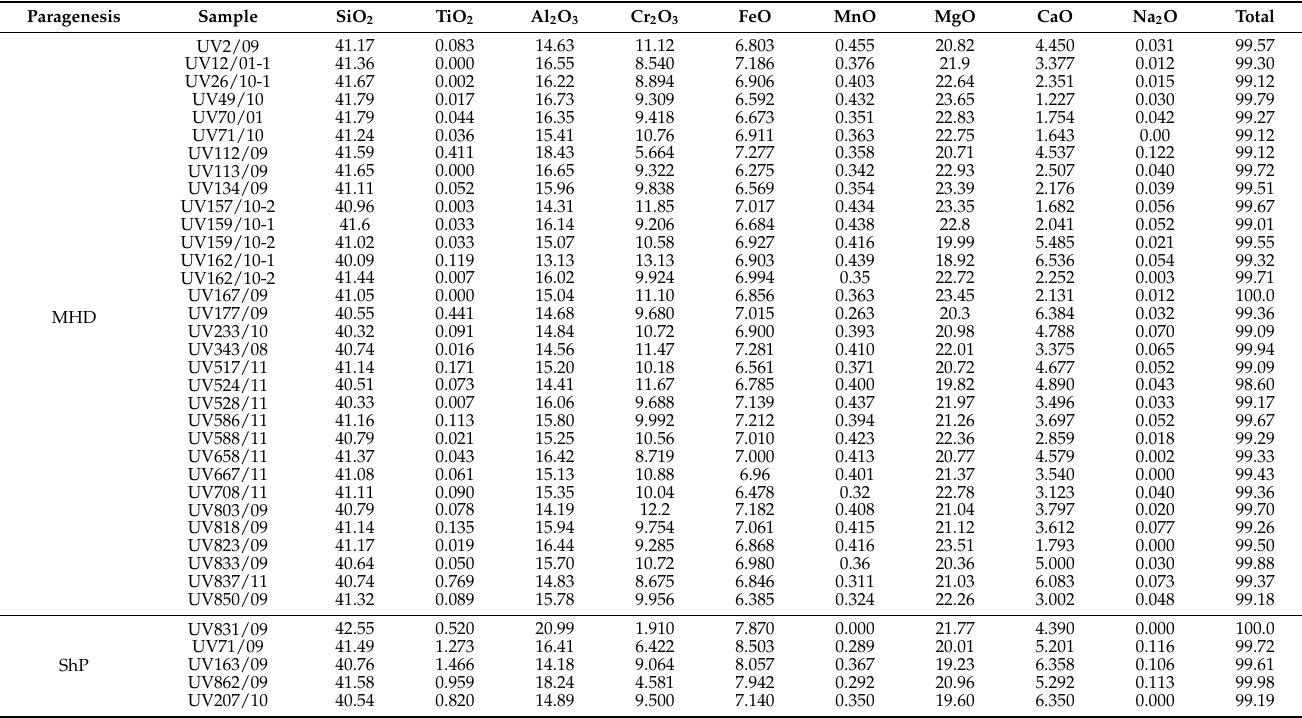
Table A1. Chemical compositions (wt.%) of MHD and ShP garnets in Udachnaya-East kimberlite pipe (Yakutia, Russia). Paragenesis Sample